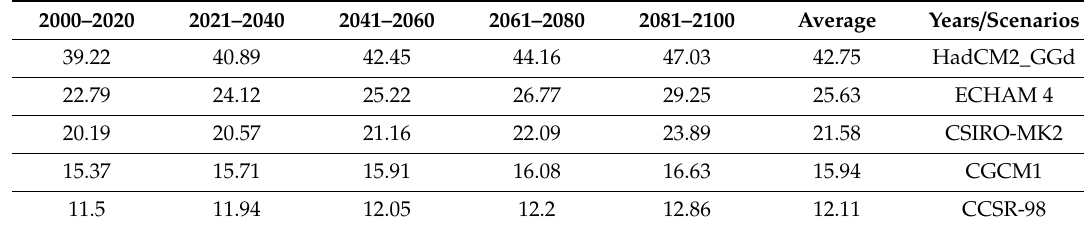
Table 5. Percentage (%) of decrease of available water for 100 years per every 20 years.